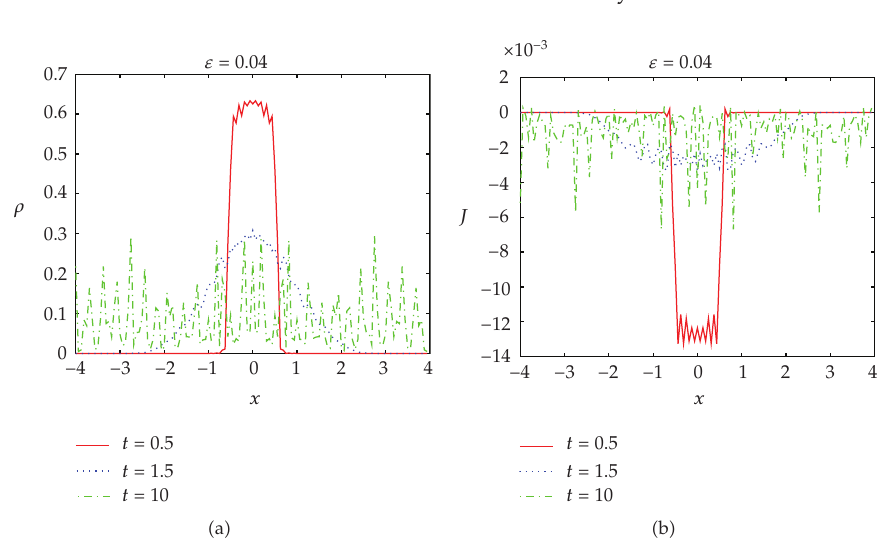
Figure 10: Numerical solutions of Example 5.3 by ED2/EP2 for the strong O (cid:3) 1 (cid:4) cubic defocusing nonlinearity (cid:3) λ (cid:6) 1 (cid:4) , ε (cid:6) 0 .